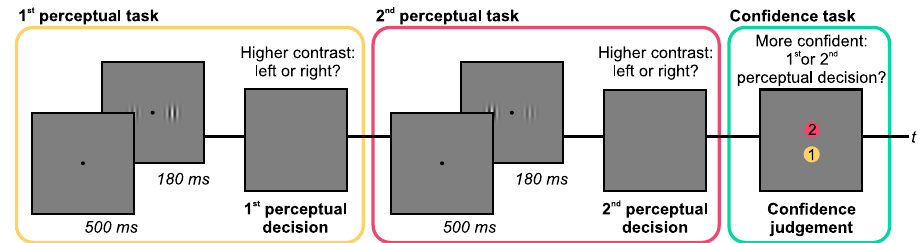
Figure 1. Trial procedure of the confidence forced-choice paradigm. Participants were presented with two consecutive perceptual tasks in which they had to decide which of two simultaneously presented Gabor patches appeared higher in contrast. After the second perceptual decision, they were asked for a confidence judgement, i.e. they had to indicate which of the two perceptual decisions they felt more confident about. Please note that colour is here used to illustrate the consecutive steps in each trial and was not used in the actual